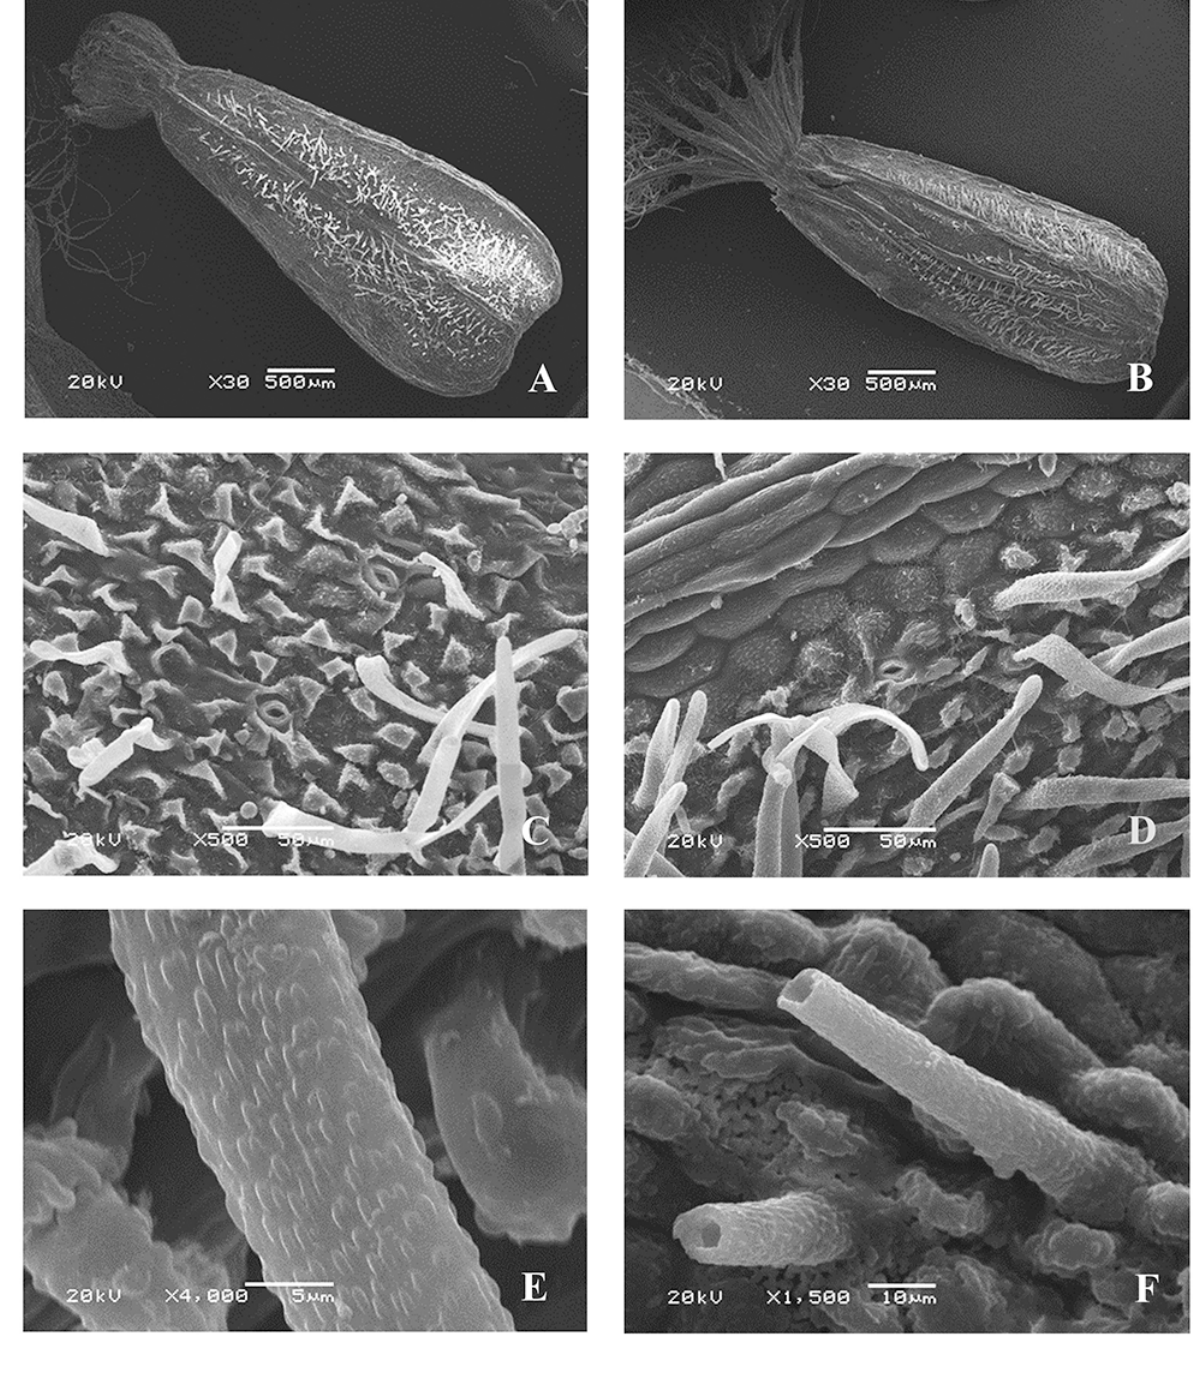
Figure 5 Fruit of Valeriana officinalis var. nitida (Kreyer) Rostanski (SEM): General view, adaxial side ( A ); general view, abaxial side ( B ); fragments of the fruit surface ( C,D ); hairs ( E,F ).